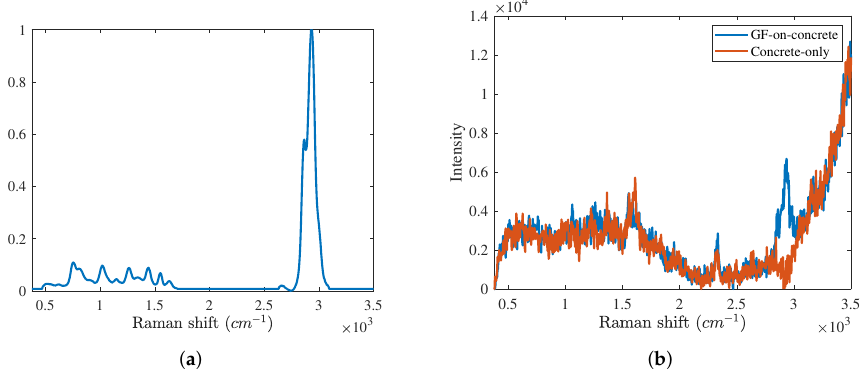
Figure 2. ( a ) Reference spectrum of the cyclosarin (GF), ( b ) GF-on-concrete and concrete-only